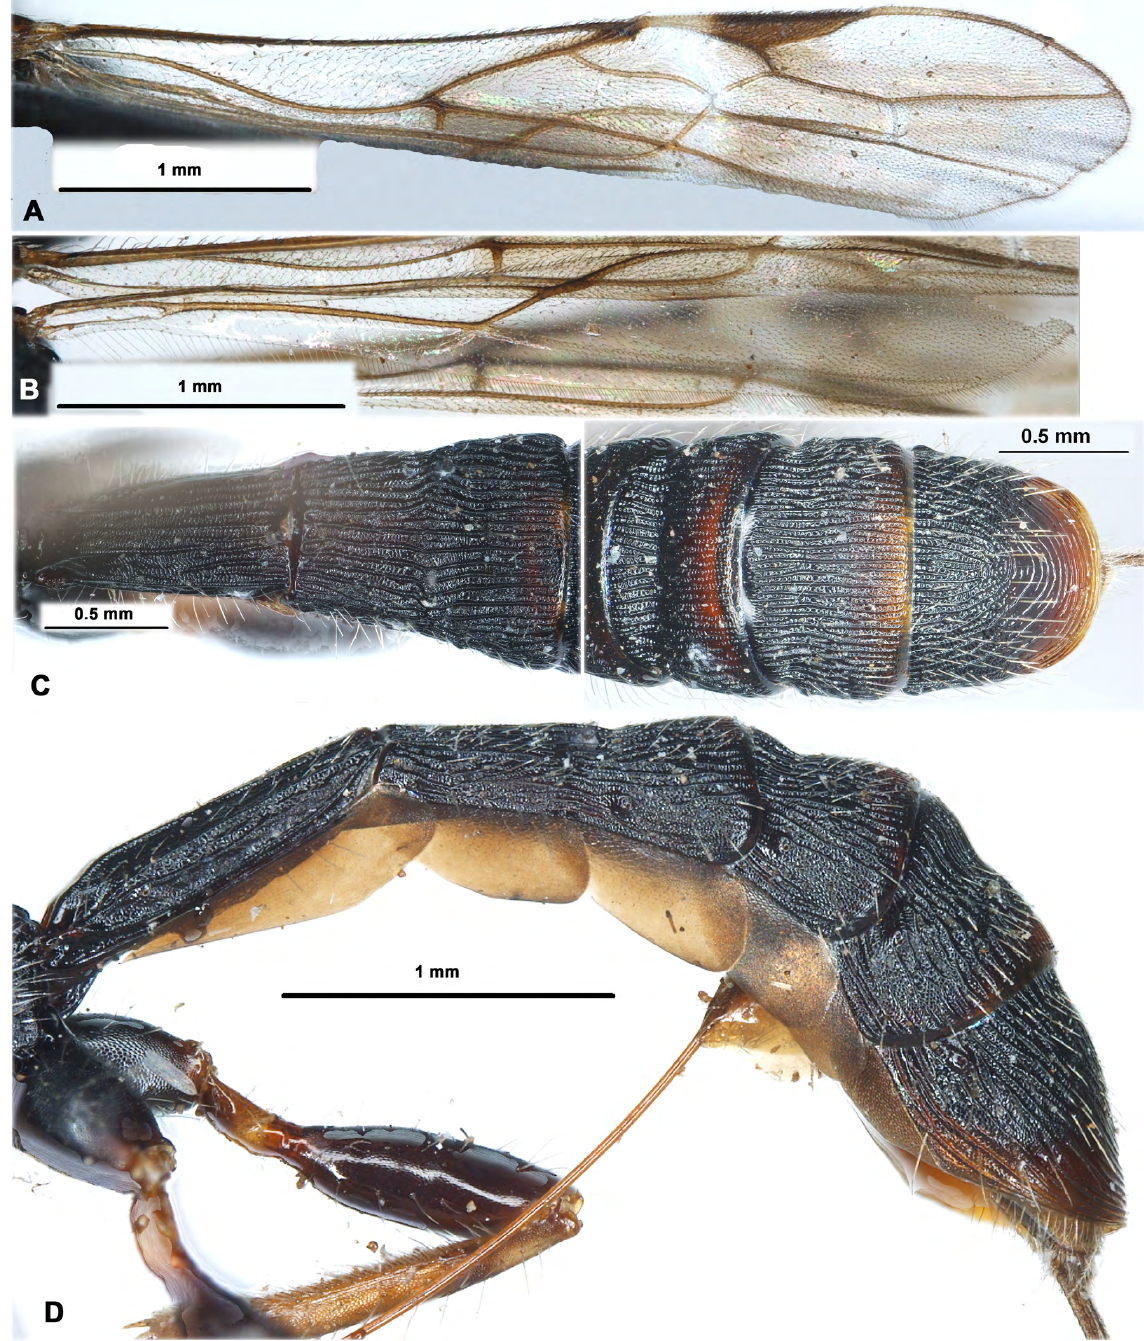
Fig. 59. Troporhaconotus jacobsoni (Szépligeti, 1908) gen. et comb. nov., ♀, holotype, HNMN. A . Fore wing. B . Hind wing. C . Metasoma, dorsal view. D . Metasoma, lateral